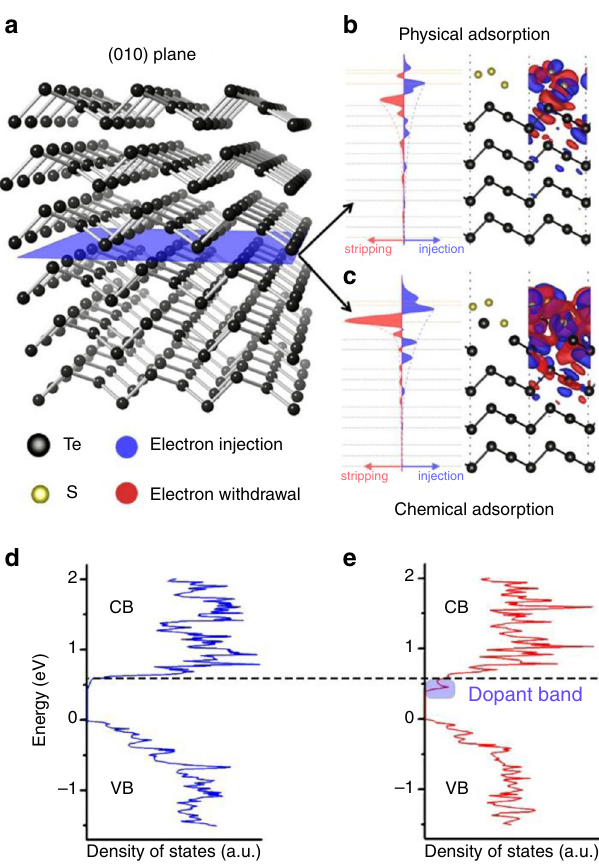
Fig. 3 Charge transfer and evolution of a resonant dopant band with sulfur doping. a Illustration of the atomistic structure and (010) surface, of the hexagonal tellurium nanowire using density functional theory calculations. The supercell con fi guration and the charge-transfer effect for b physical adsorption and c chemical adsorption of equal amount of sulfur adatoms on tellurium along (010) surface. The blue isosurface represents injection of electrons, and red for stripping or withdrawal of electrons. For clarity, the iso-charge contours are only shown in the right halves of b and c . Plane-integrated charge transfer along the surface normal direction is shown for both cases and is plotted with the same scale, so that they are quantitatively comparable. d , e Calculatedsurface density of states using density functional theory (DFT) for tellurium ( p -type) and sulfur-do p ed tellurium ( n -type) with CB and VB referring to the conduction and valence bands of bulk tellurium, respectively. The dotted black line denotes the edge of the CB. A new dopant band (shaded ellipse) emerges close to the conduction band edge for the sulfur-doped tellurium.